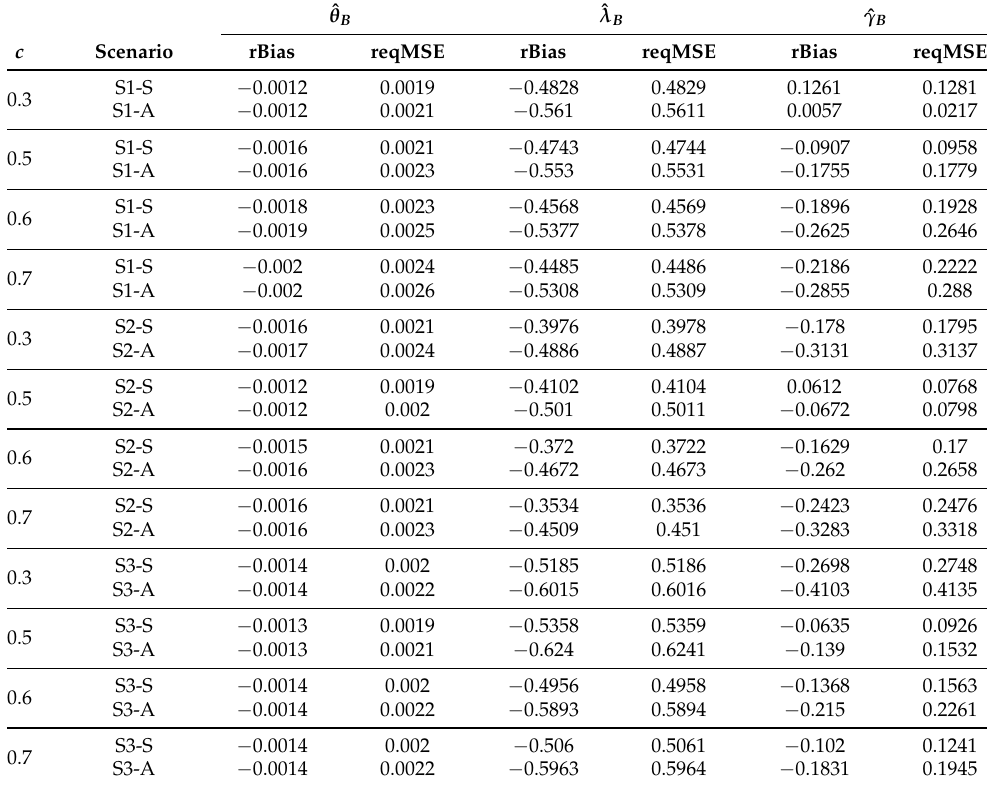
Table 4. The values of rBias and rsqMSE based on ˆ θ B , ˆ λ B and ˆ γ B for n = 100.